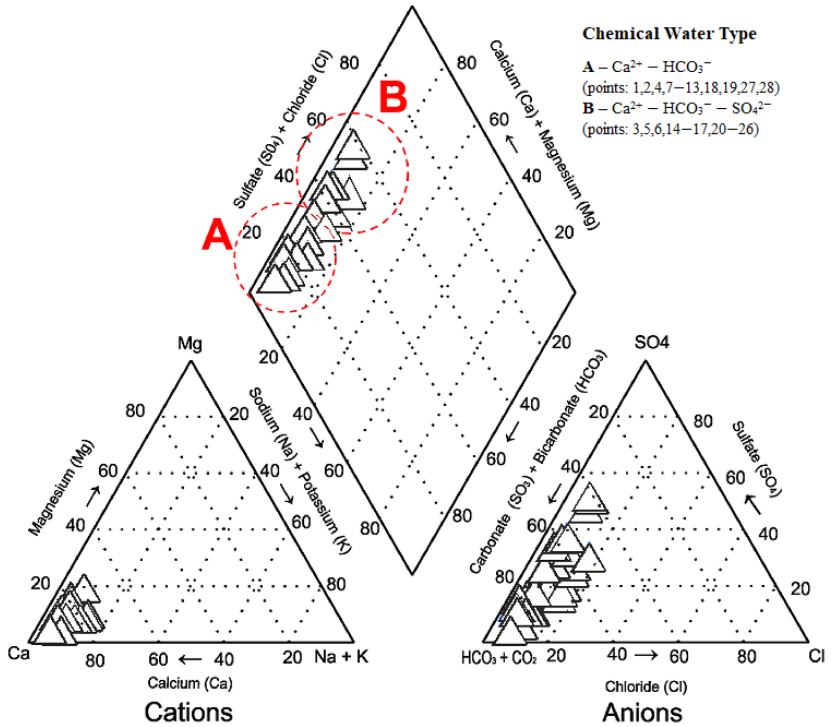
Figure 2. Concentrations of cations and anions in spring waters.